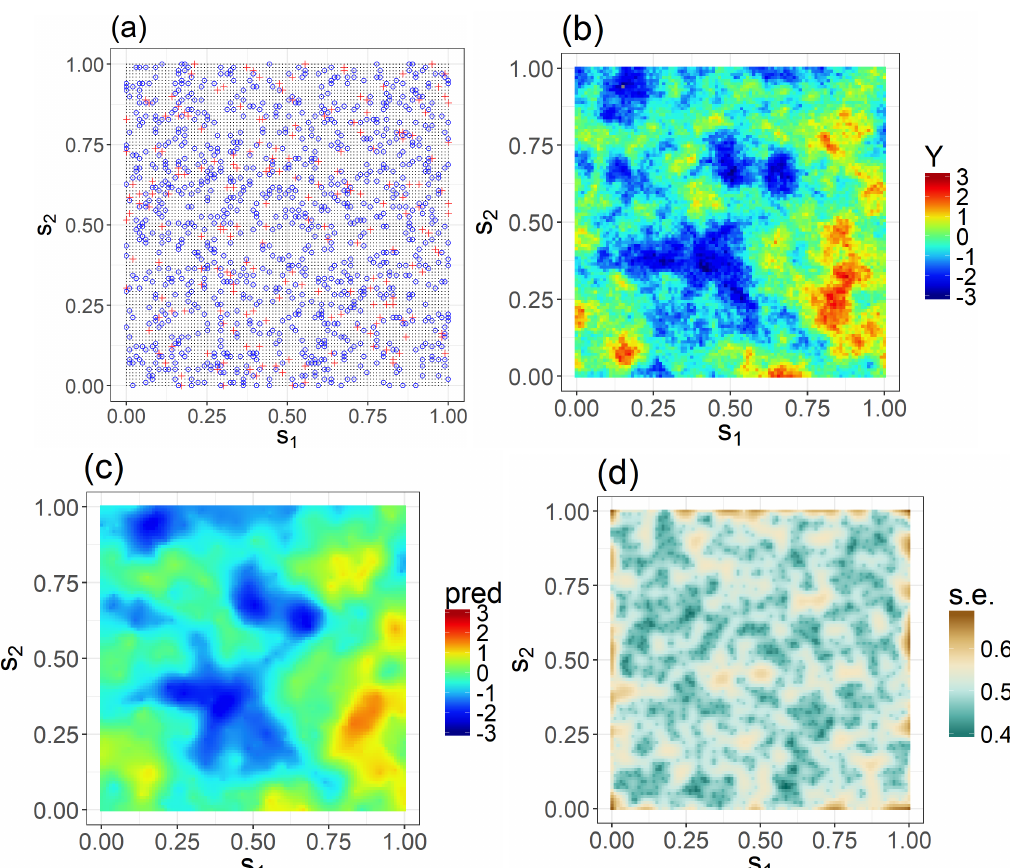
Figure 1. Simple kriging in a simulation experiment (see the text in Section 2.1 for details). ( a ) Experimental setup: the blue circles are the retrieval locations; the red crosses are the validation (unobserved) locations; and the black dots define the prediction grid at which the Level 3 maps are constructed. ( b ) The ‘true’ unobserved process of interest Y . ( c ) The simple kriging predictor (pred) in process space on the prediction grid from the simulated retrievals. ( d ) The prediction standard errors (s.e.) obtained as part of simple kriging on the prediction grid.